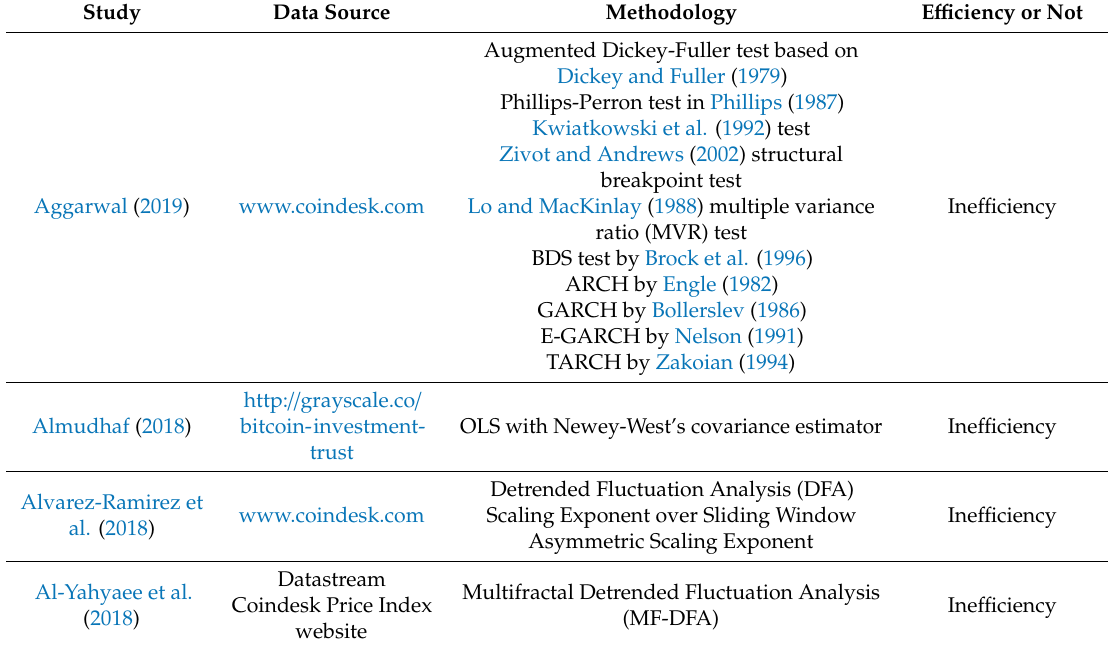
Table 1. Studies about EMH in cryptocurrency markets with data sources, methodology and conclusions about level of ine ffi